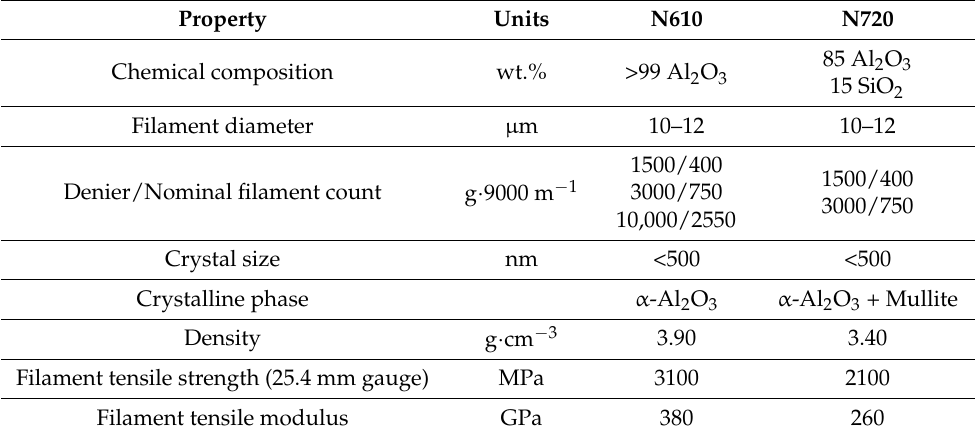
Table 1. Typical properties of N610 and N720 single fibers